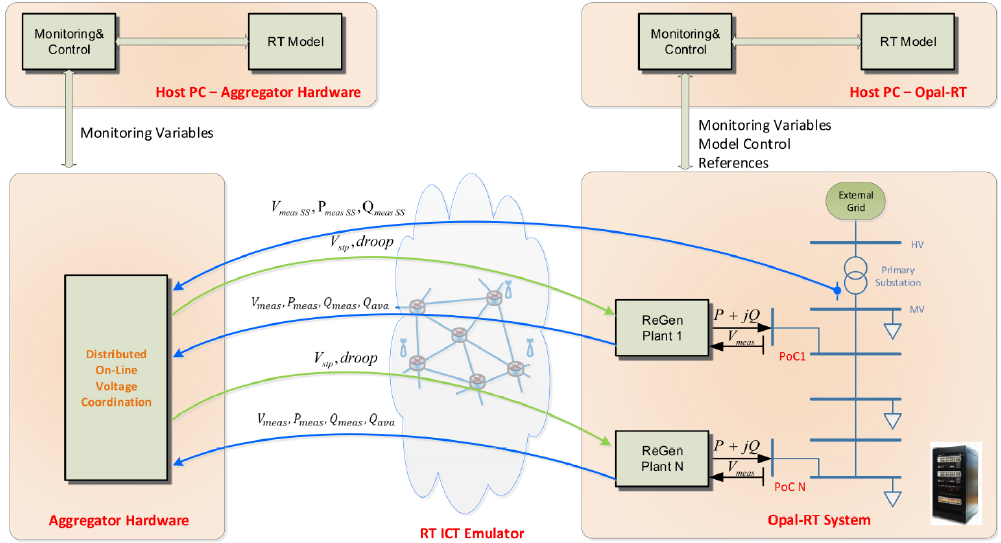
Figure 6. RT-HIL setup used for validation of distributed online voltage